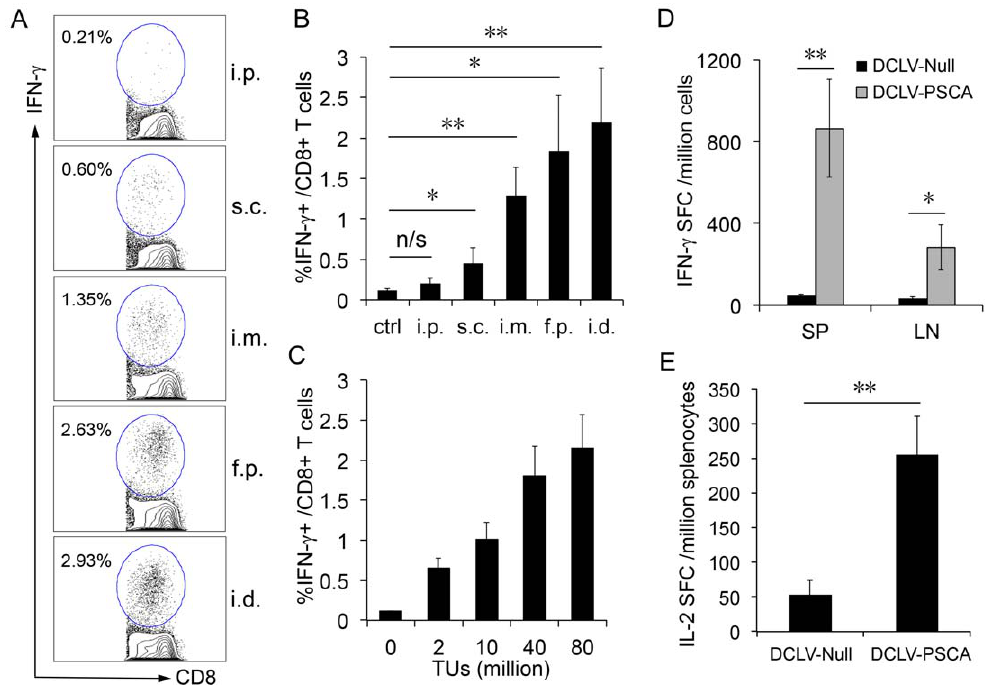
Figure 2. PSCA-specific T cell response after a single dose of invivo immunization with DCLV-PSCA. (A) Male C57BL/6 mice were immunized with 6 6 10 7 TU of DCLV-PSCA through different administration routes: intraperitoneal space (i.p.), subcutaneous area (s.c.), intramuscular area (i.m.), footpad (f.p.), or intradermal (the base of tail, i.d.). One immunization group was included as a negative control. Two weeks after immunization, splenocytes from mice were harvested and analyzed for the presence of PSCA-specific CD8 + T cells by restimulating splenocytes with a PSCA peptide (PSCA 83-91 ), followed by intracellular staining for IFN- c and surface staining for CD8. Percentage of IFN- c -secreting CD8 + T cells is indicated. (B) Statistical comparison of immunization elicited by administration of DCLV-PSCA among different administration routes. (C) Male C57BL/ 6 mice were immunized with different doses of DCLV-PSCA vectors (0, 2, 10, 40 and 80 million TU) at the base of tail. Two weeks post-vaccination, PSCA-specific CD8 + T cells from the spleen were analyzed by restimulating with the peptide PSCA 83-91 , followed by intracellular staining for IFN- c . (D) Production of PSCA-specific IFN- c -secreting cells from both spleen (SP) and inguinal lymph node (LN) was evaluated by restimulation with the PSCA 83-91 peptide, followed by ELISPOT analysis for IFN- c . (E) Production of PSCA-specific IL-2 from splenocytes (with CD8 + T cells depleted) was measured by restimulation with 293T cell lysate transfected to express PSCA, followed by the ELISPOT analysis for IL-2. (**: P , 0.01; *: P , 0.05; One- way ANOVA followed by Bonferroni’s multiple comparison test. Error bars represent SD.) All experiments were repeated three times and the representative data is